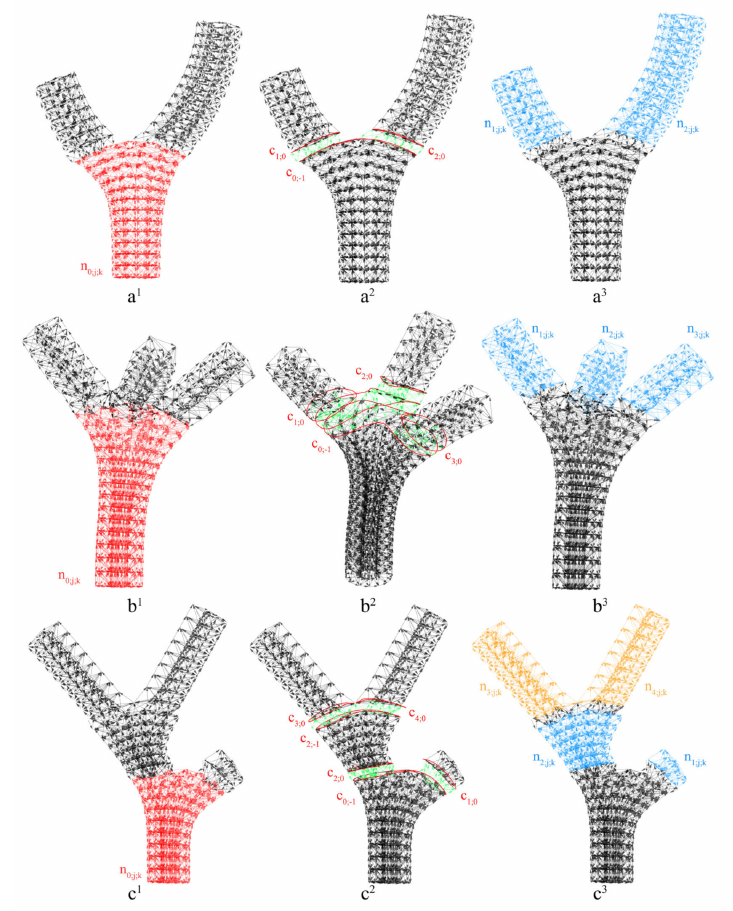
Figure 10. Prototype Lattice Generation: ( a ) two-branch geometry; ( b ) multi-branch geometry; ( c ) multi-level-branch